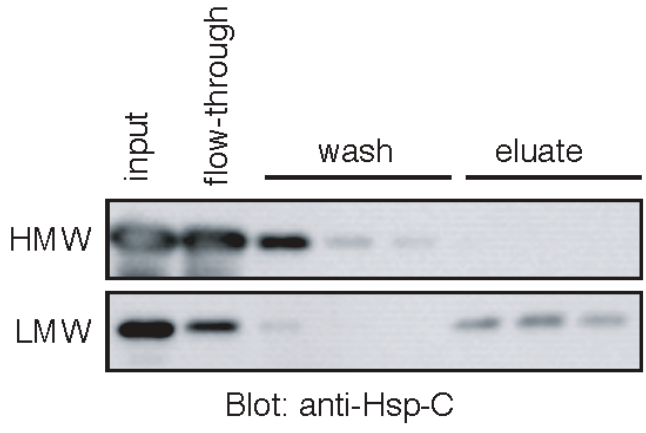
Figure 4. The HMW Hsp70 loses ATP-binding activity. The HMW (top panel) and low molecular weight (LMW) (bottom panel) Hsp70 (1 mL each) prepared as described in “Experimental Section” were incubated with ATP-agarose. The beads were washed and the bound Hsp70 was eluted with 5 mM ATP. All fractions (100 (cid:2)L) were precipitated with TCA and analyzed by Western blot using anti-Hsp-C